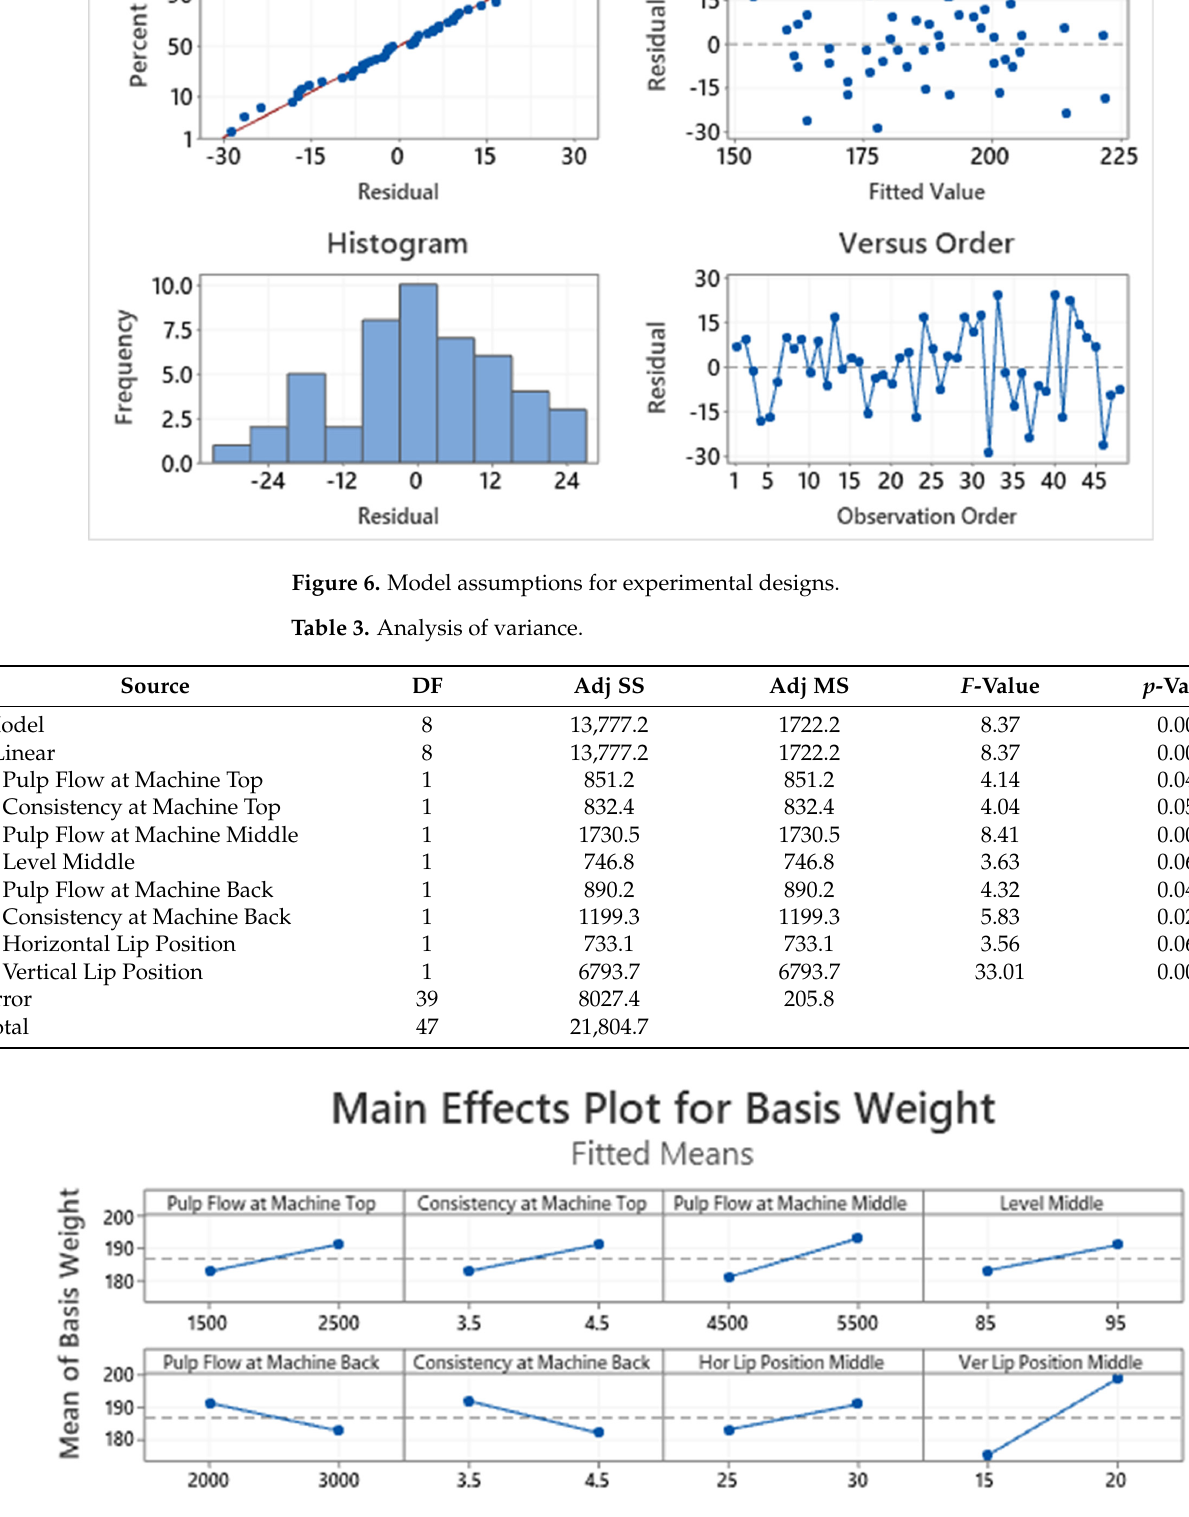
Figure 7. Main effects for the independent variables. Table 4. Optimal values for the independent variables and expected variability.